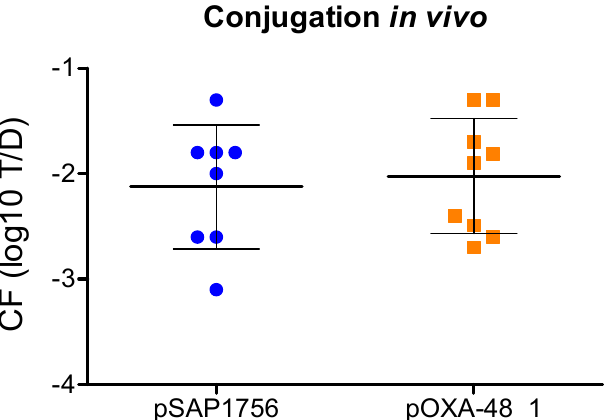
Figure 3. Conjugation frequency (CF) of IncM2 NDM-1-carrying plasmid pSAP1756 and IncL OXA- 48-carrying plasmid pOXA48_1 using E. coli MG1655 resistant to nalidixic acid as donor and E. coli MG1655 resistant to rifampicin as recipient. Blue circles and orange squares represent the logarithm of transconjugants per donor obtained per experiment after 4 h conjugation in Galleria mellonella inoculated with ~10 7 CFU of donors and recipients separately. Horizontal lines show the mean and vertical lines the standard deviation of at least 8 independent experiments.